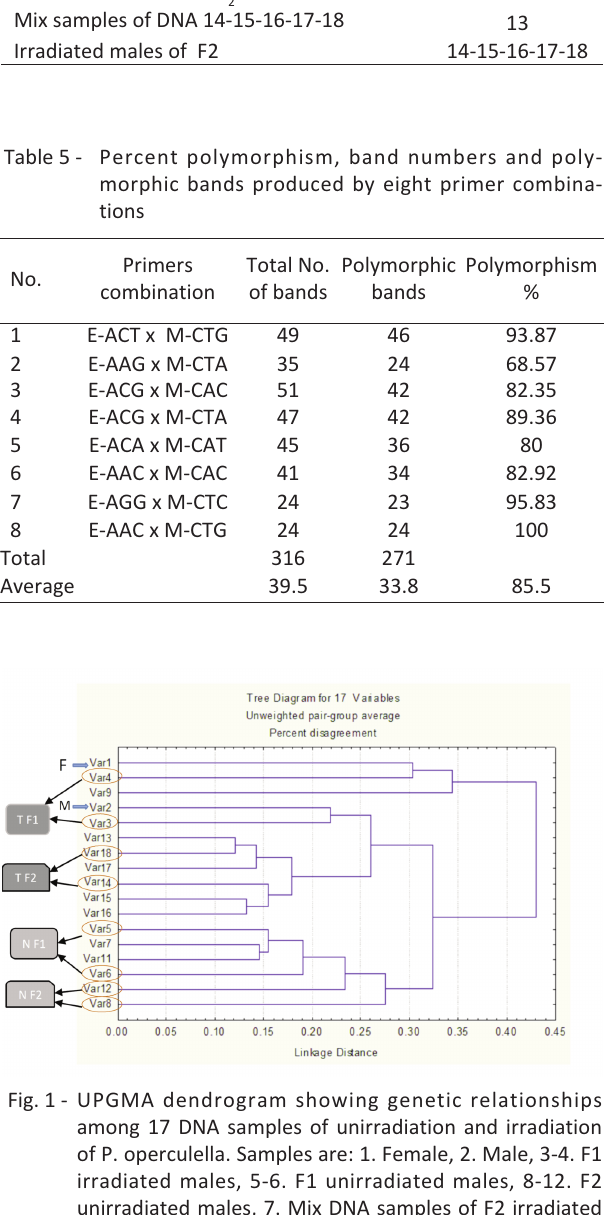
1999; Idris et al ., 2019). Thus, the sterility in F IST applied against P. operculella (Makee and Saour,